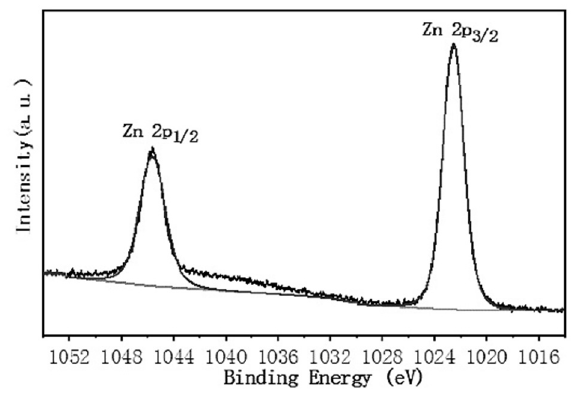
Figure 13. The Zn2p3/2 at 1021.8 eV and the Zn2p1/2 at 1044.8 eV correspond to the existence of ZnO.